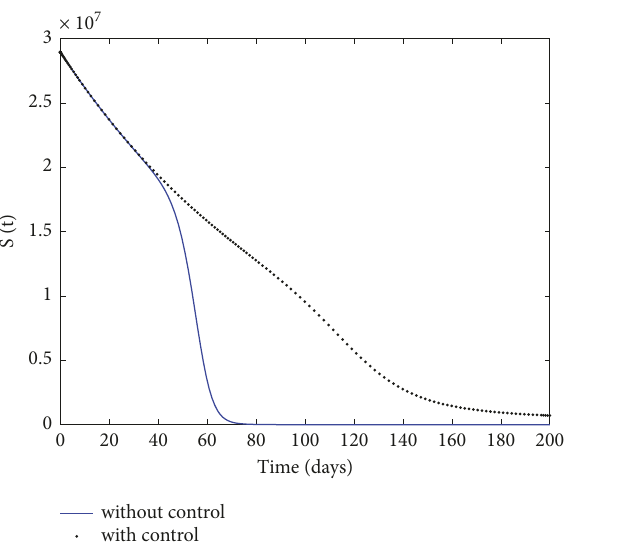
Figure 11: Behaviour of the susceptible population with and without lockdown control.